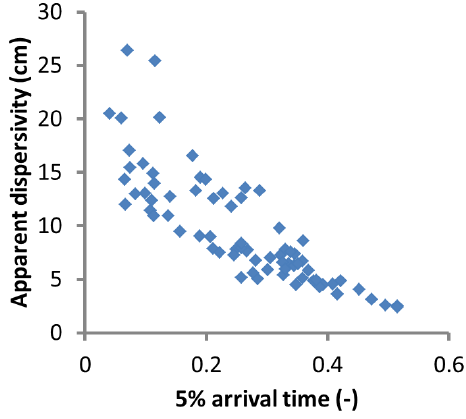
Figure 6. Correlations between measures of preferential transport.